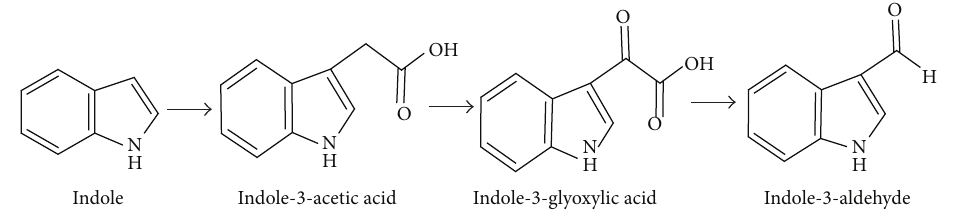
Figure 4: Proposed pathway of indole transformation for Arthrobacter sp.